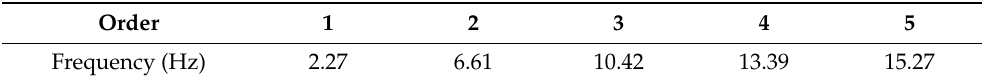
Figure 2. Numerical model. Table 1. Model